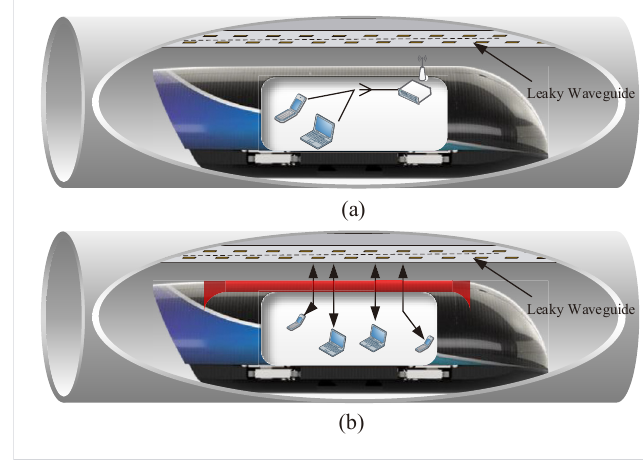
Figure 4. Wireless access solutions for vactrain: ( a ) Mobile relay station and ( b ) Leaky lens